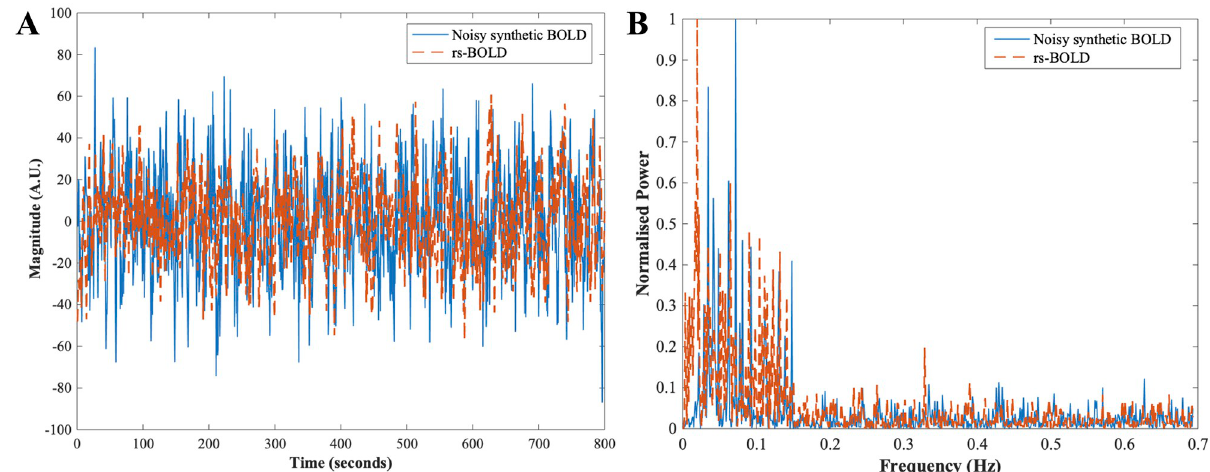
Fig 3. Comparison between the generated noisy synthetic BOLD and the rs-BOLD signal from one of the ROI from dataset. (A) The time series plot of the generated noisy synthetic BOLD (cyan-colored) and preprocessed rs-BOLD (dashed orange curve). (B) Power spectrum plot of the noisy synthetic BOLD (cyan) and rs-BOLD